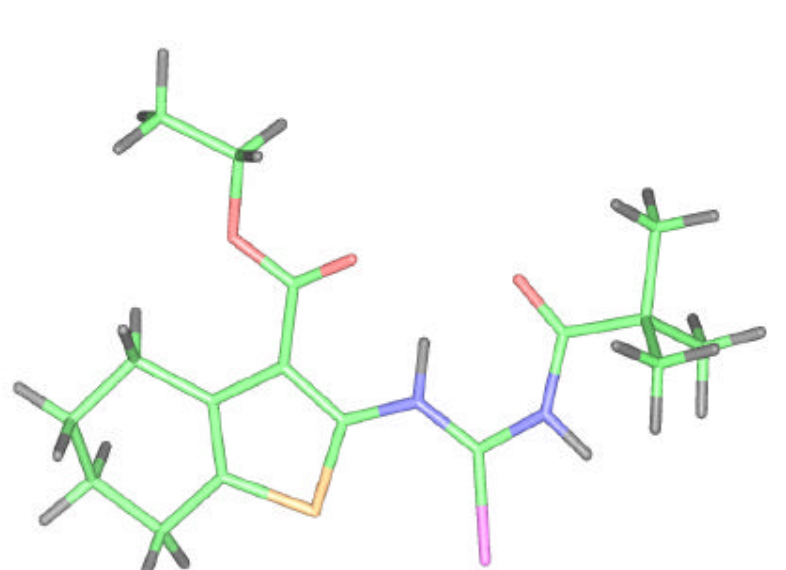
Figure 4. Molecular design of 2 according to the computational